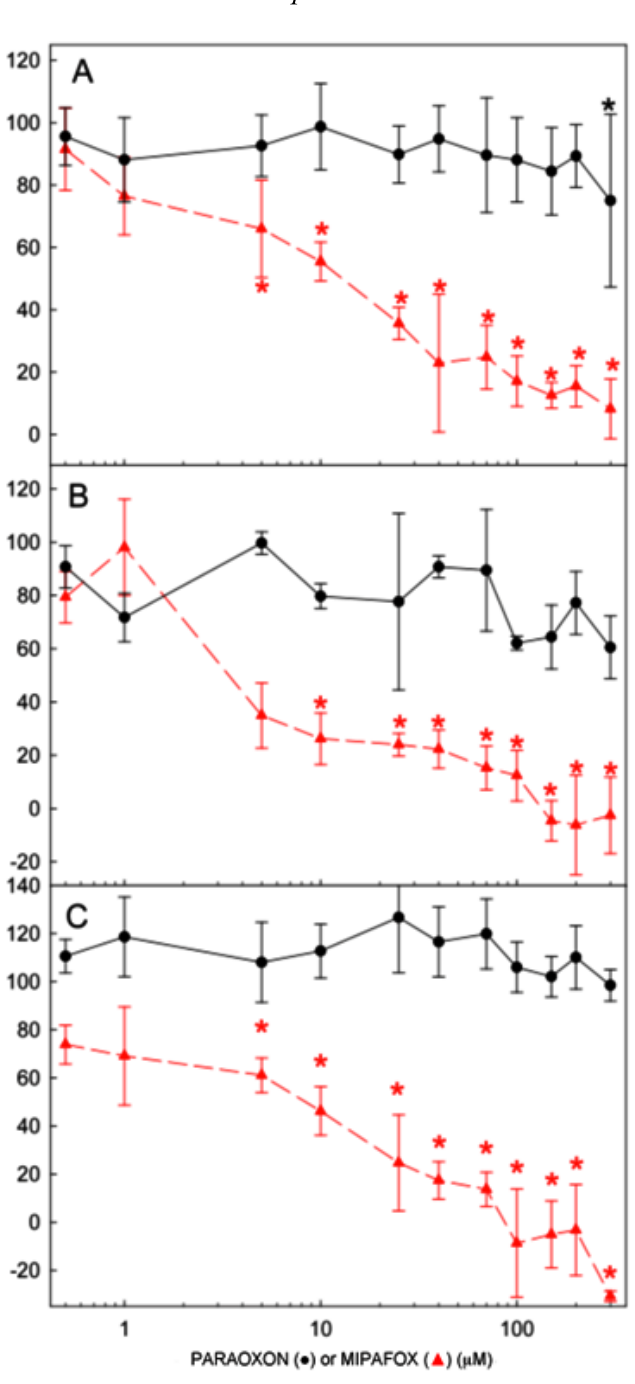
Figure 3. Changes in NTE activity of the NT2 cells exposed to paraoxon or mipafox during the neurodifferentiation process. Cells were exposed to 0.5, 1, 5, 10, 25, 40, 70, 100, 150, 200 and 300 µM of either paraoxon ( ● ) or mipafox ( ▲ ) for 4 days ( A ); 10 days ( B ); and 15 days ( C ). NTE activity is expressed as the percentage of activity determined in the time-matched control (non-exposed) cultures. Data represent mean ± SEM of three independent experiments with 8 technical replicates for each experimental condition. ( * statistically different from the controls for p < 0.05 with a Dunnett’s